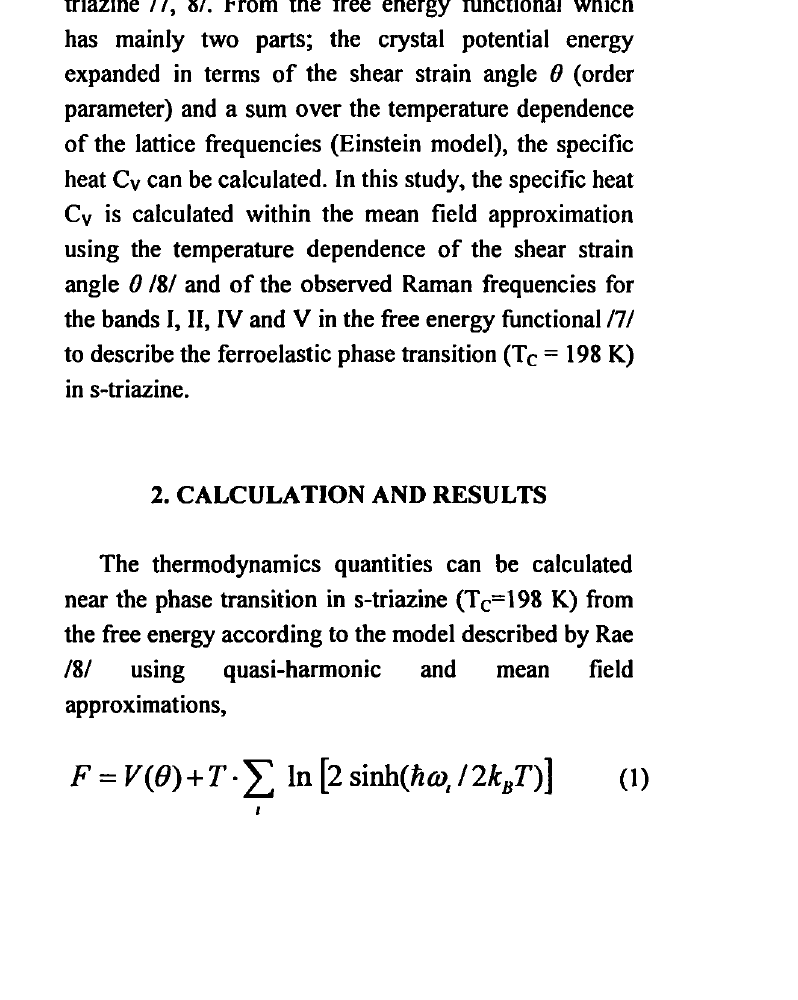
1: The temperature dependence of the shear strain angle θ and molecular rotation angle φ as order parameters for s-triazine, as determined by Smith and Rae 121 and by Prasad et al. /13/. Dynamical behaviour of the coupled system of molecular orientations and acustic phonons has been investigated to describe the ferro-elastic